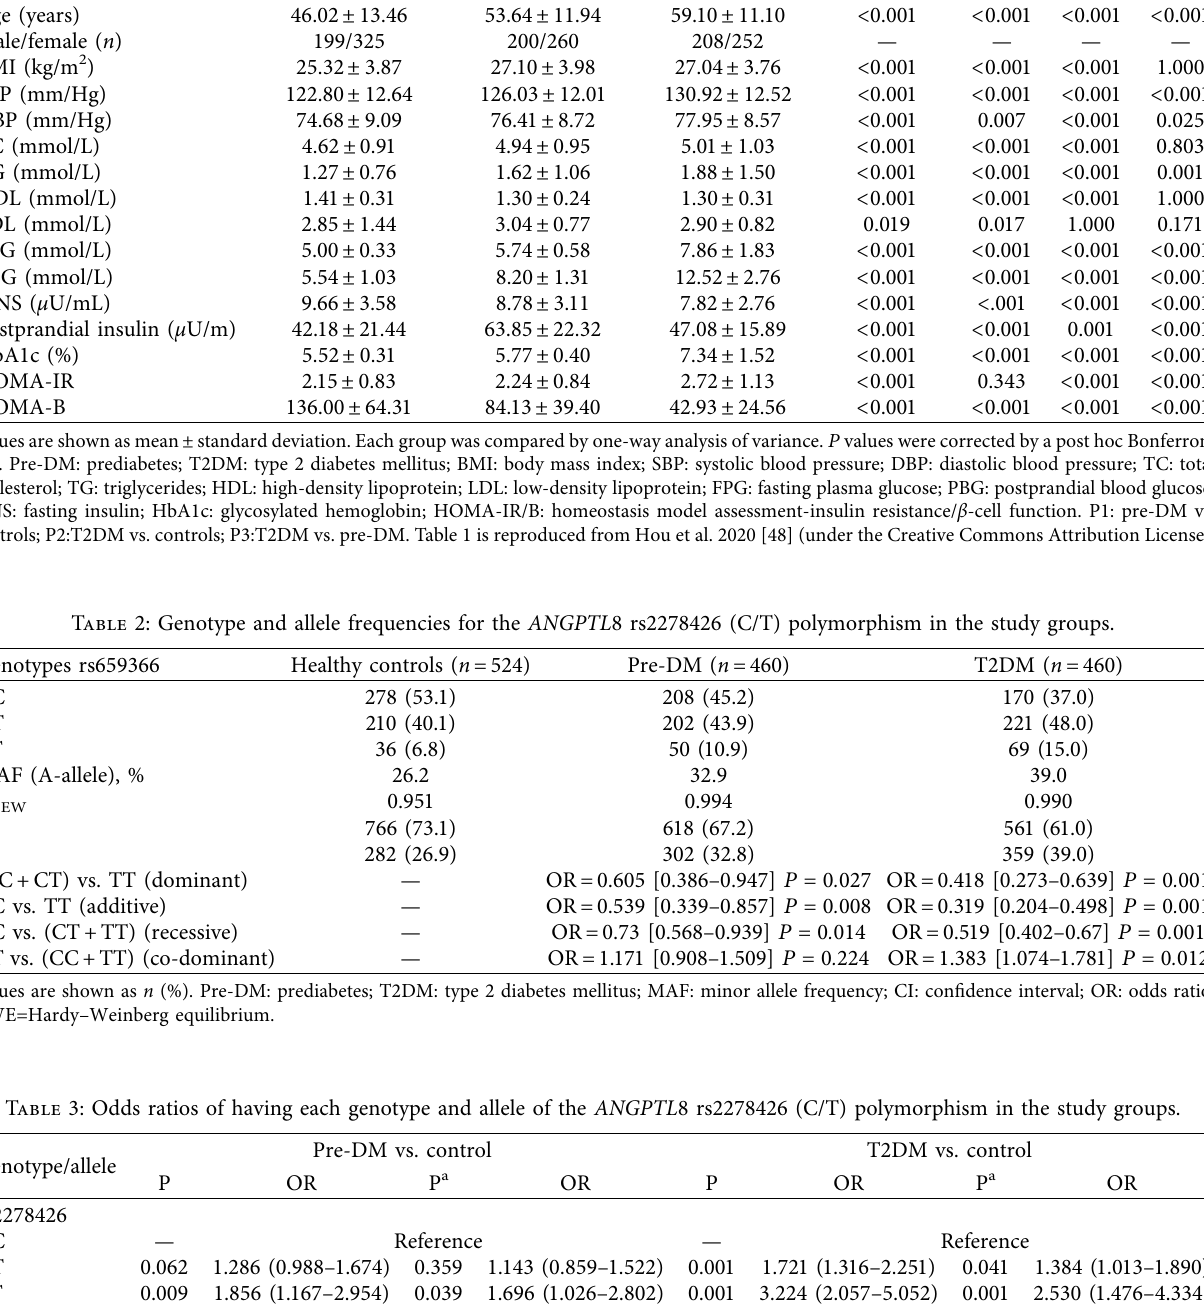
Groups All P values